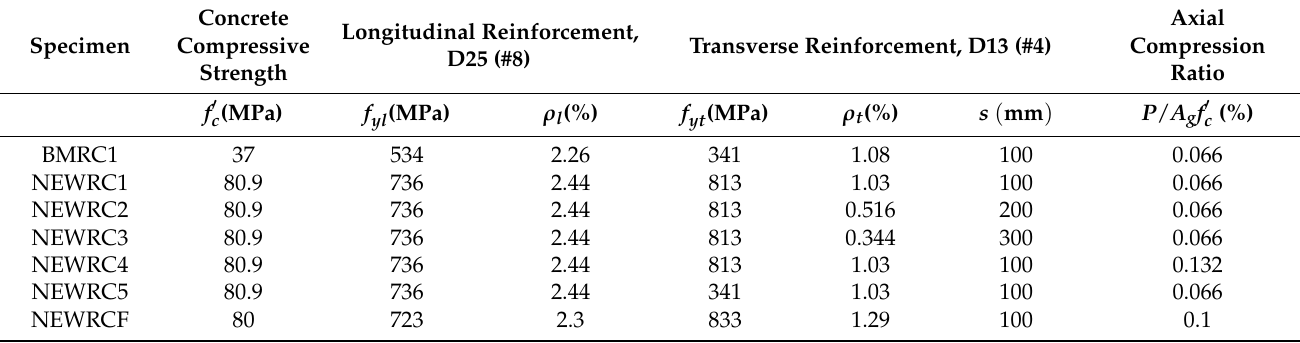
Table 2. Column and frame design parameters.